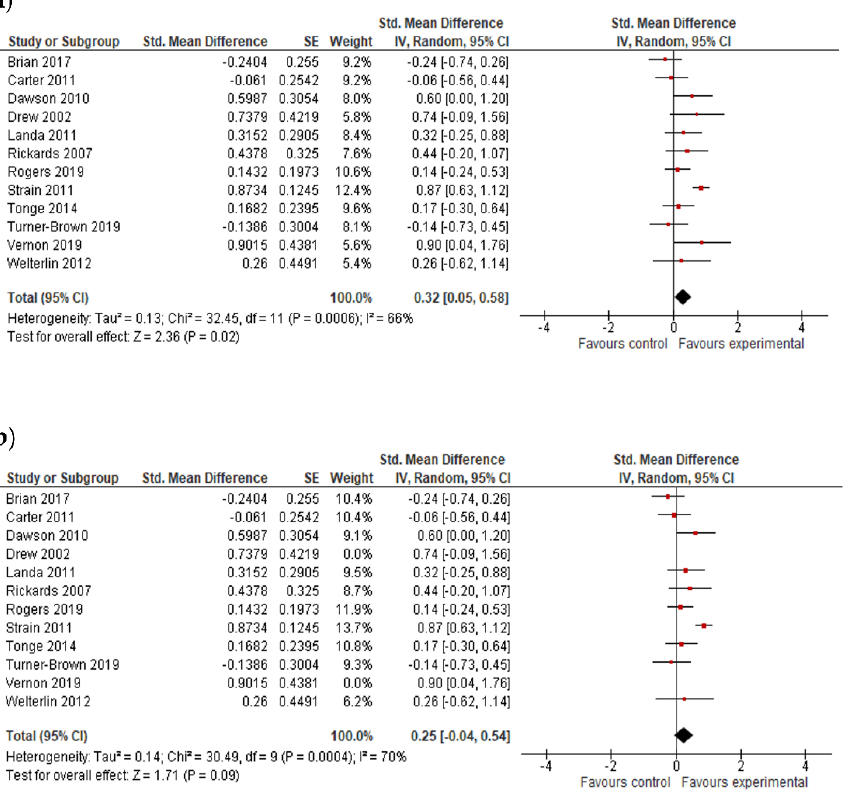
Figure 3. Forest plots for cognitive ability results. ( a ) Overall effect [28–30,32,41,46,49,54–56,58,59]. ( b ) Results after exclusion of studies with no blinding of outcome assessment [28–30,41,46,49,54–56,58,59].